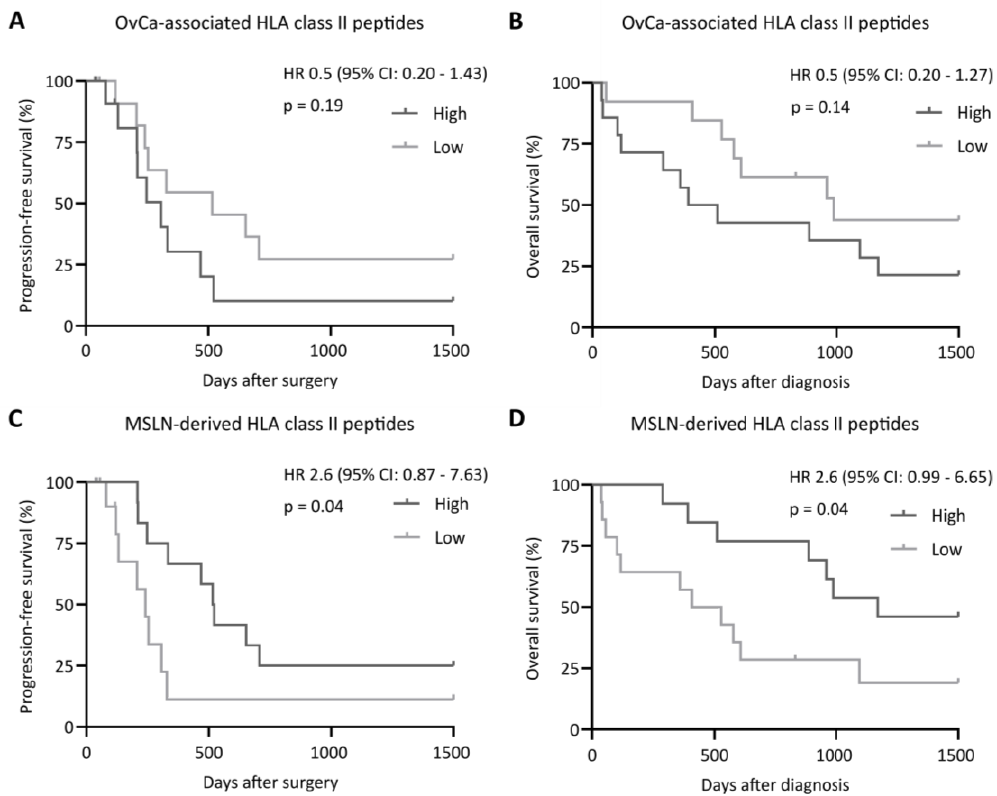
Figure 2. Impact of tumor-associated and MUC16-derived HLA class I-restricted peptide presenta- tion on clinical outcomes. Impact of ( A , B ) OvCa-associated and ( C , D ) MUC16-derived HLA class I- restricted peptide presentation on ( A , C ) progression-free and ( B , D ) overall survival rates, according to antigenic peptide presentation. Kaplan – Meier analysis, log-rank test. Abbreviations: HR, hazard ratio; CI, confidence interval; and p , p -value.